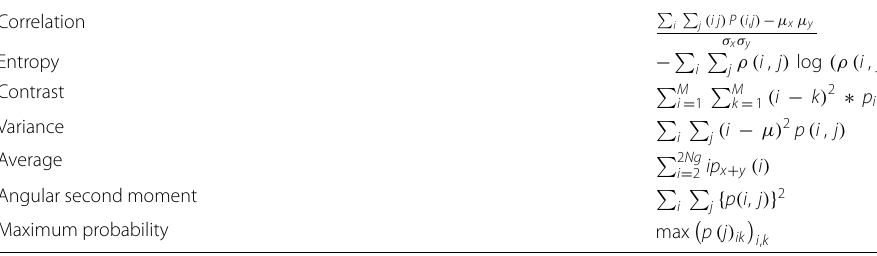
Local energy based shape histogram